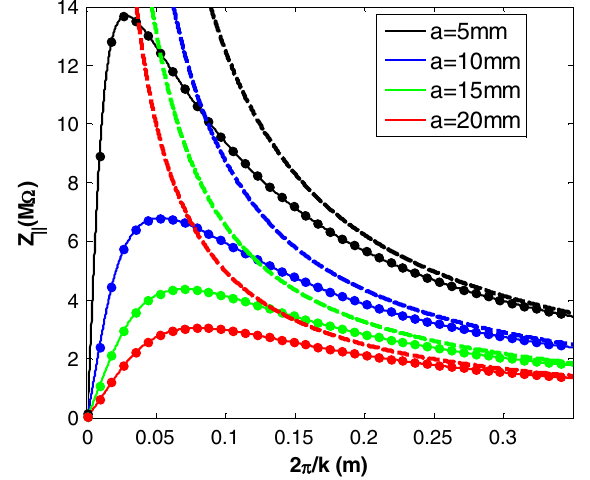
FIG. 10. The shielding effect of a rectangular chamber on the on-axis impedance. The round uniform beam has a radius of a , the full widths and heights of the chamber are w ¼ h ¼ 4 a , 6 a , 8 a , 10 a , 12 a , 14 a and 16 a , which correspond to the lower to upper black lines as clearly shown on the right part of the plot.